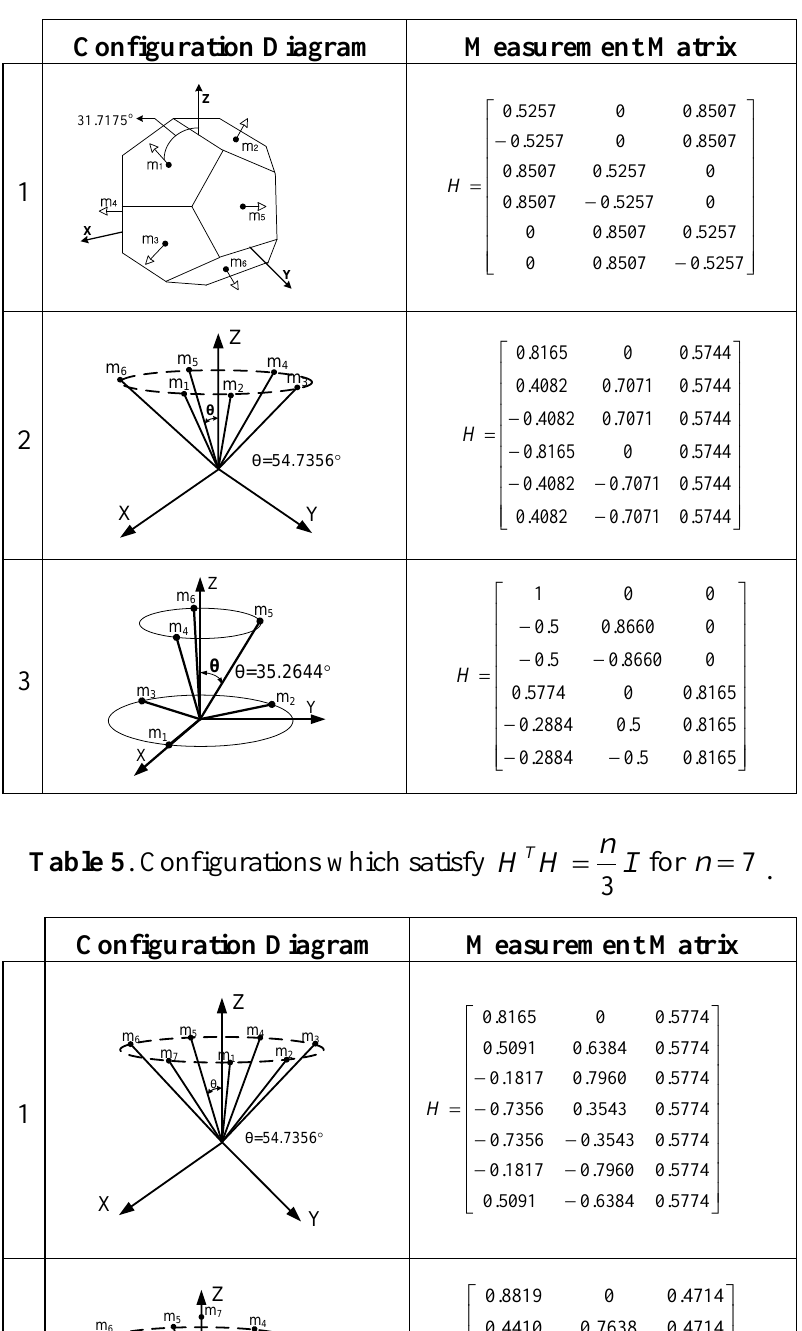
In HH T  for 6  n . 3